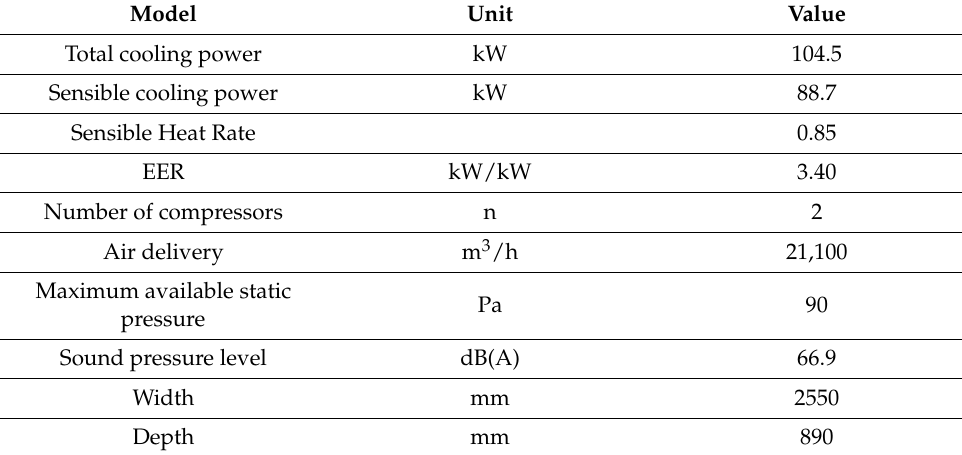
Table 3. Technical specifications of the Dual Fluid equipment (adapted form